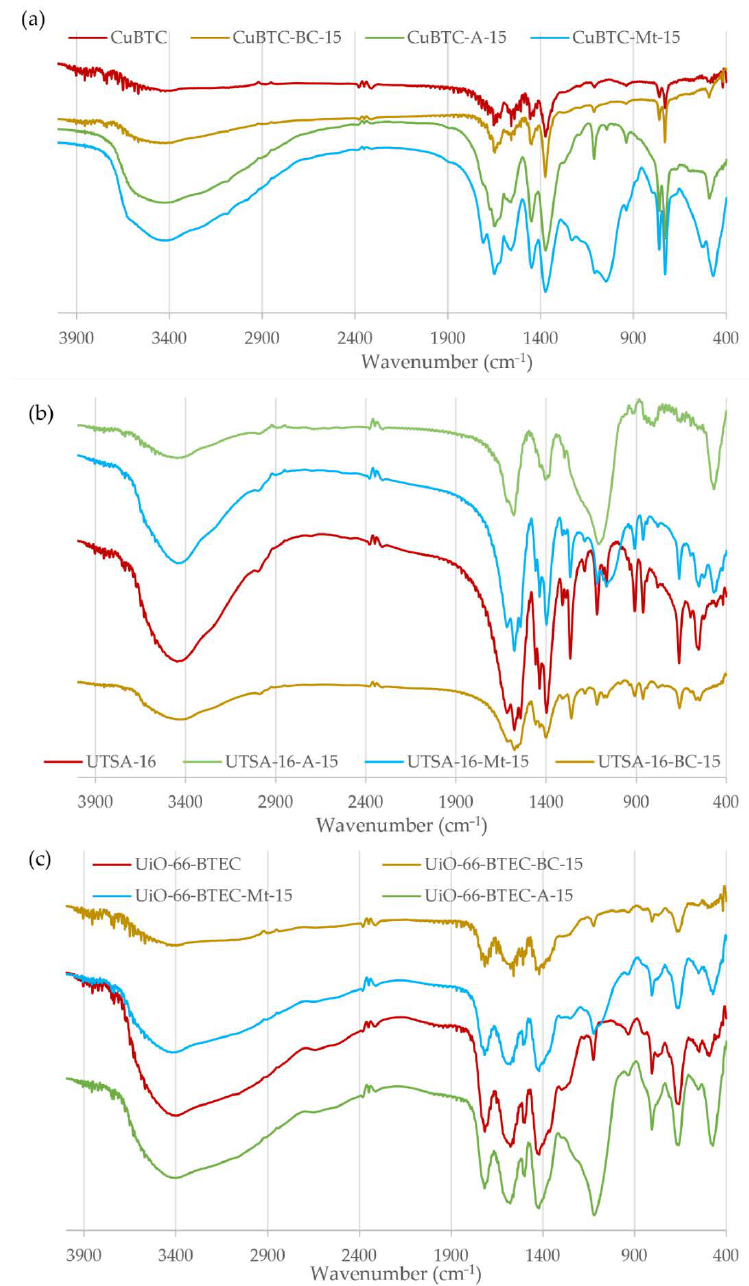
Figure 4. FTIR spectra of ( a ) CuBTC and CuBTC-composites containing aerosil (CuBTC-A-15), montmorillonite (CuBTC-Mt-15), and biochar (CuBTC-BC-15), ( b ) UTSA-16 and UTSA-16-composites containing aerosil (UTSA-16-A-15), montmorillonite (UTSA-16-Mt-15), and biochar (UTSA-16-BC-15), ( c ) UiO-66-BTEC and UiO-66-BTEC-composites containing aerosil (UiO-66-BTEC-A-15), montmorillonite (UiO-66-BTEC-Mt-15), and biochar (UiO-66-BTEC-BC-15).